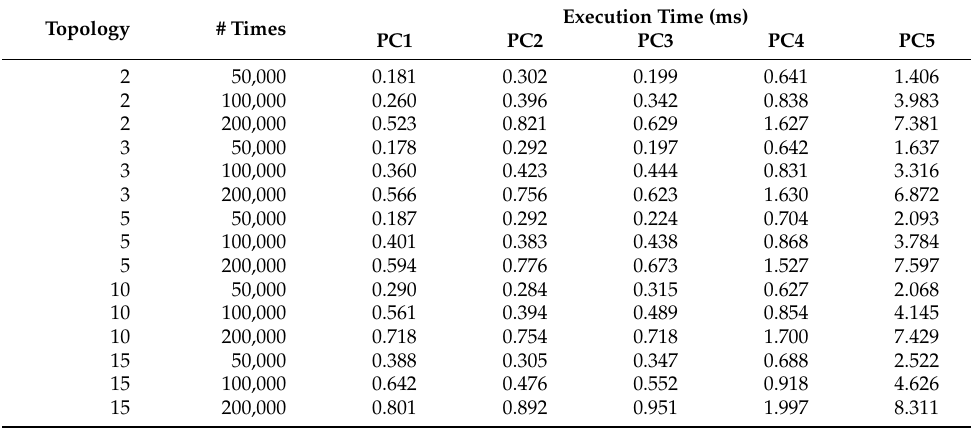
Table 8. Performance evaluation of parallel identical